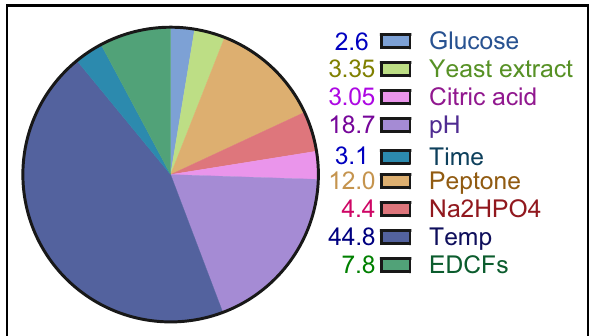
Figure 2. A Pareto chart for PBD that uses EDCFs as a source for carbon and nitrogen to explain the relative importance of each factor in % and its effect on BC